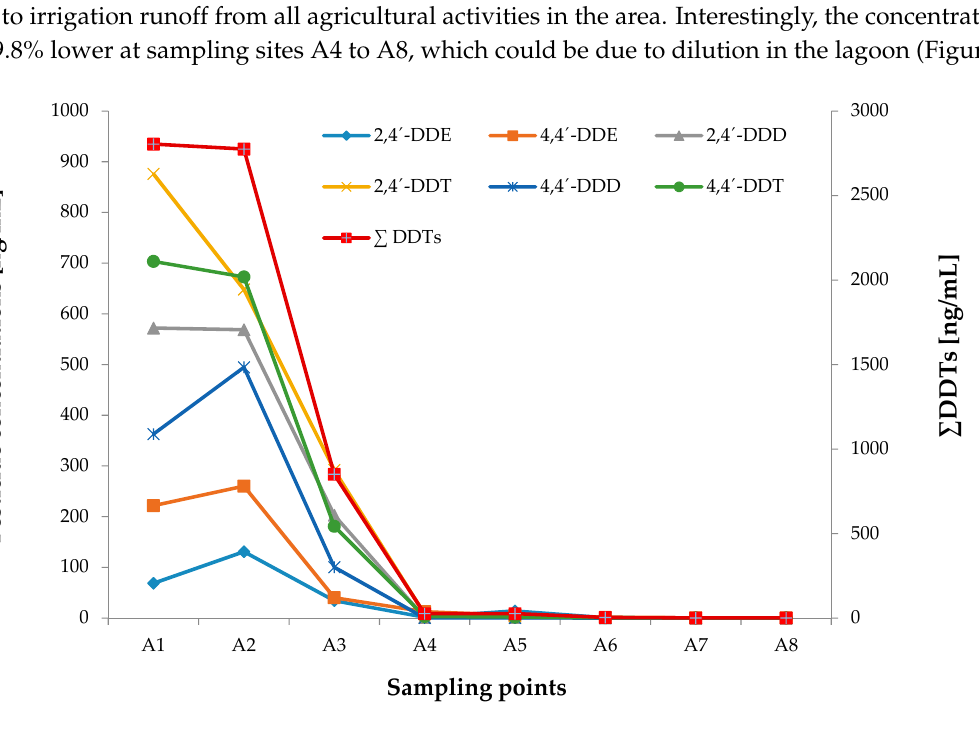
Figure 3. Distribution and concentrations of DDT and its metabolites in zone 3.